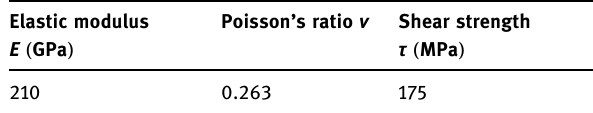
Table 1: Mechanical properties of 45 steel